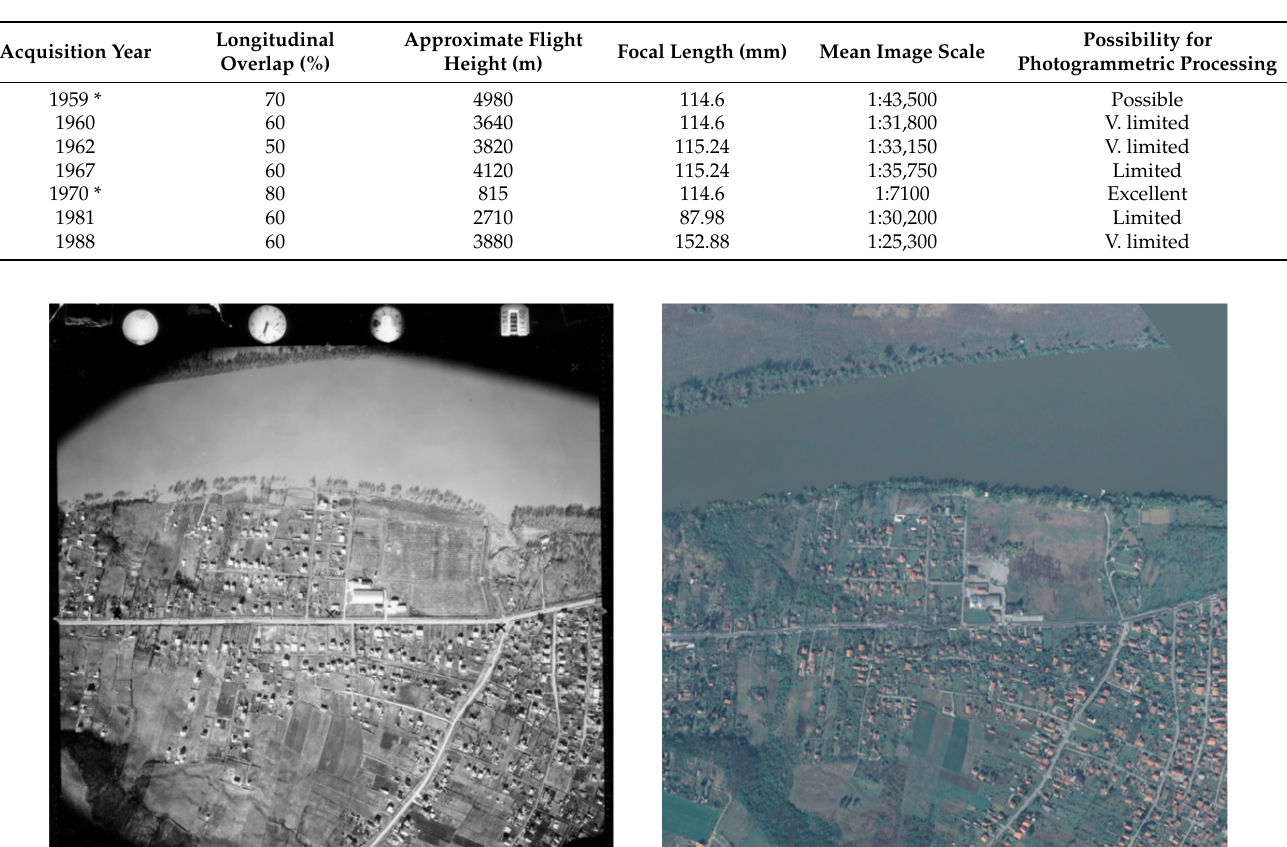
Table 1. The possibility of using historical analog aerial photographs for photogrammetric pro- cessing and analysis of the “Umka” landslide. * indicates the sets of photographs that were used during the preparation of this paper.